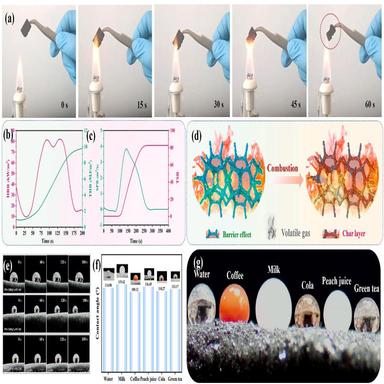
(a) Real-time digital photos of PW-CMF@Co/NC-900 composite PCMs by the vertical combustion test using alcohol lamp; The results of (b) HRR and THR; (c) SPR and TSR of PW-CMF@Co/NC-900 composite PCMs by the cone calorimeter test; (d) Schematic illustration of the flame retardancy mechanism of PW-CMF@Co/ NC composite PCMs; (e) The dynamic wetting behavior of the PW-CMF@Co/NC composite PCMs; (f) The contact angle of PW-CMF@Co/NC-900 composite PCMs with different droplets; (g) The photos of PW-CMF@Co/NC-900 com